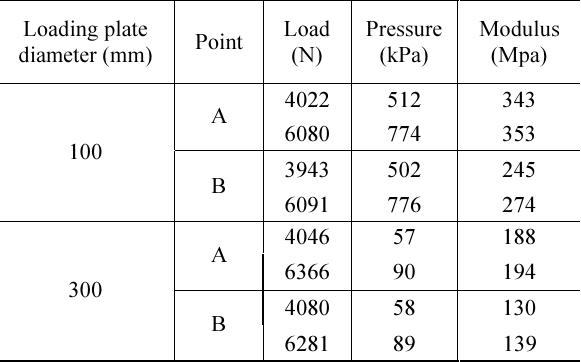
Table 3. The effects of plate diameter on PFWD moduli